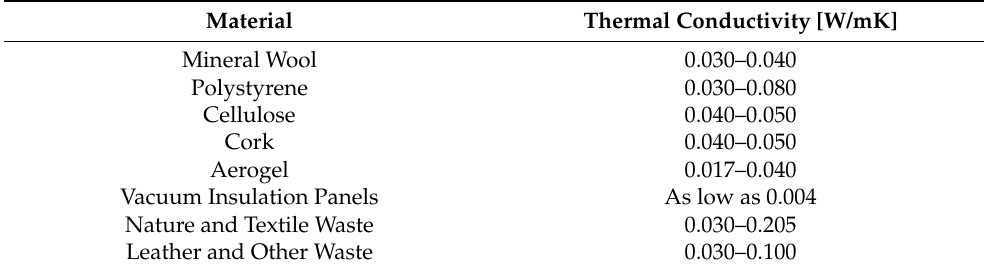
Table 1. Ranges of thermal conductivity for different insulators material